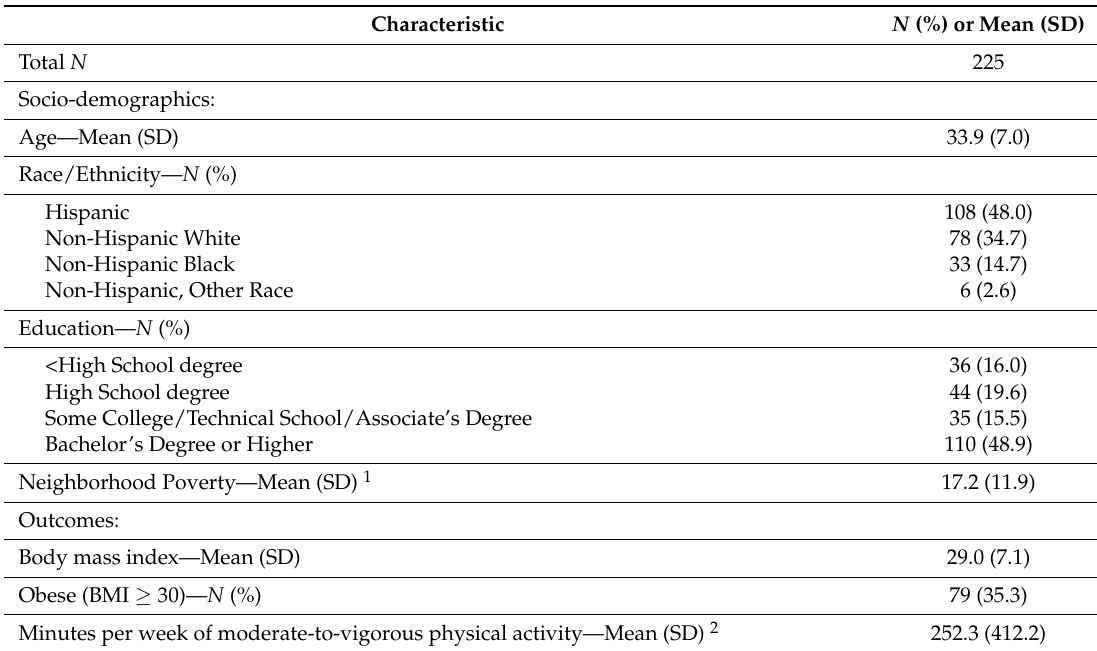
Table 2. Characteristics of Study